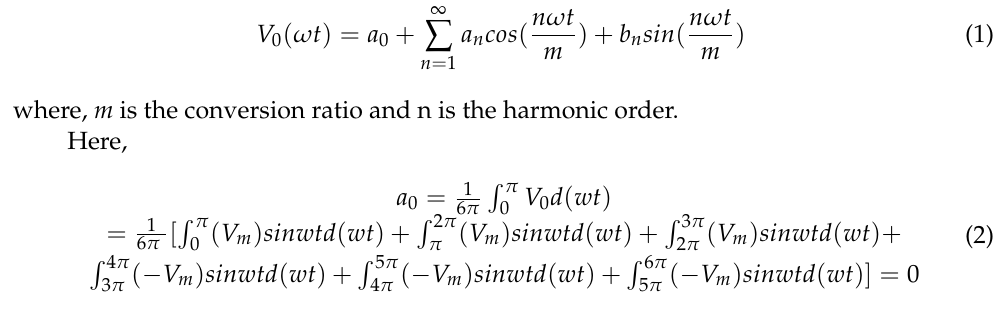
Figure 6 . Firing pulses of different Triac of proposed cycloconverter for one − third conversion of 50 Hz.